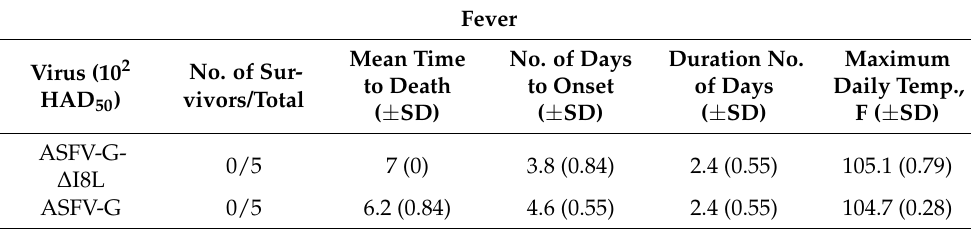
Table 1. Swine survival and fever response following infection with ASFV-G- ∆ I8L and parental ASFV-G.